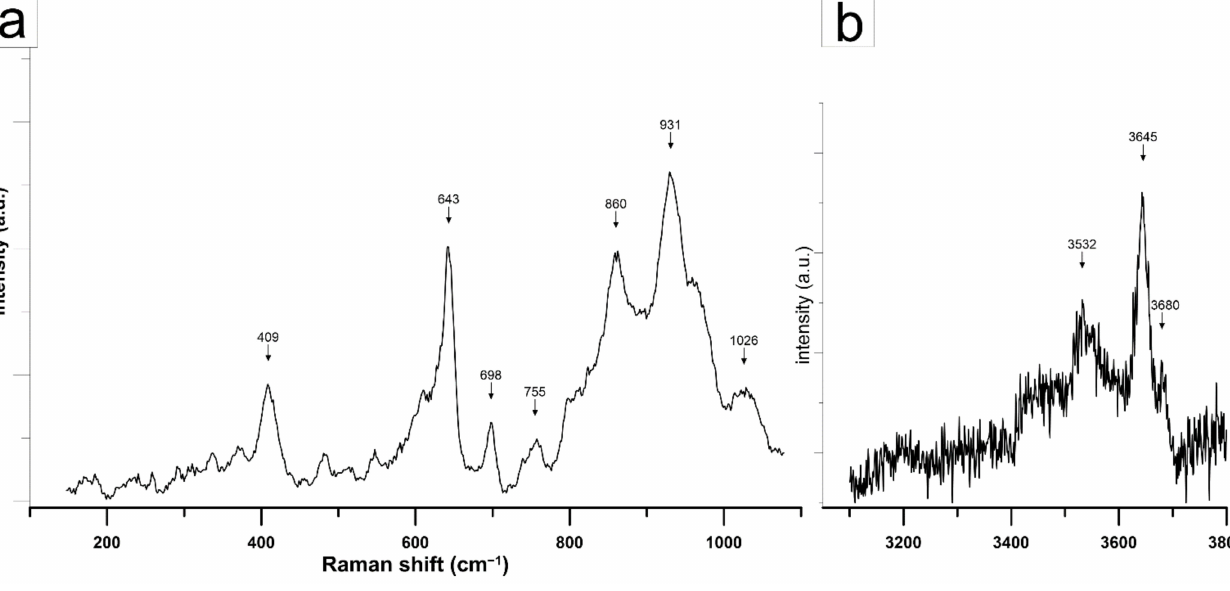
Figure 8. Representative unpolarized Raman spectrum of vesuvianite from Dobšin á ; ( a ) Low frequency region, raw spectrum; ( b ) High frequency (OH) − region, corrected to